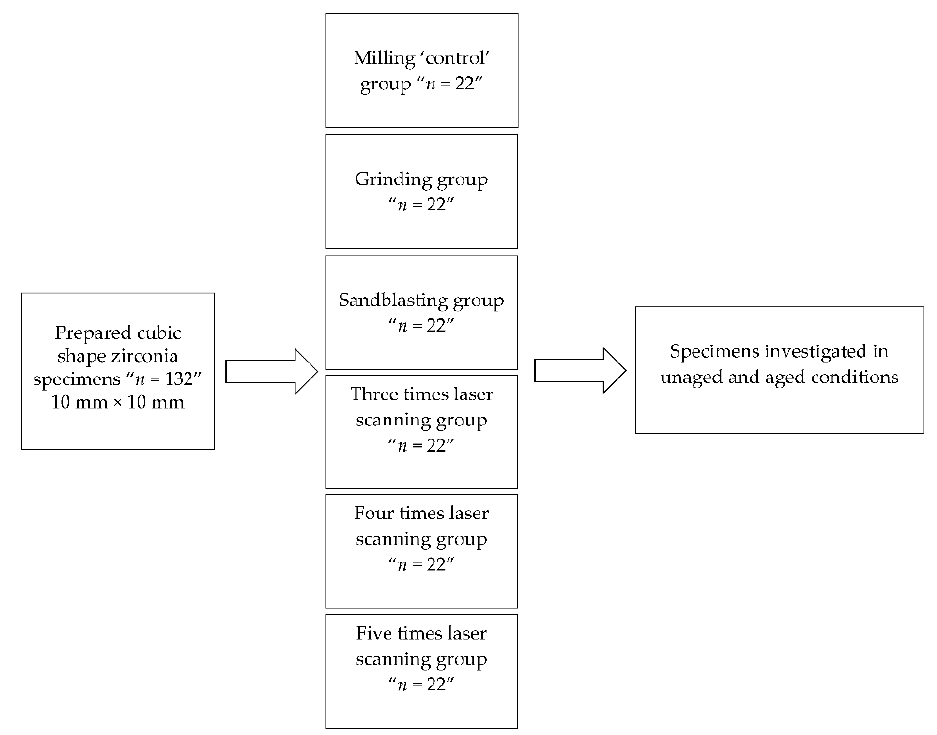
Figure 1. Flow chart summarizing the main experimental route.